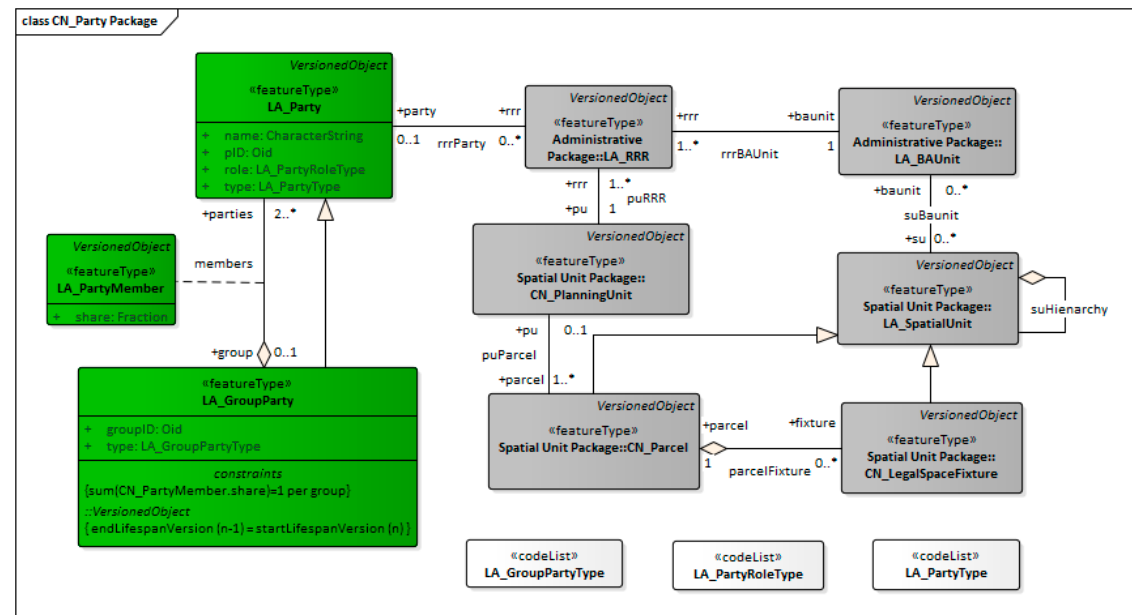
Figure 7. Party Package with Relationship (“green” part).